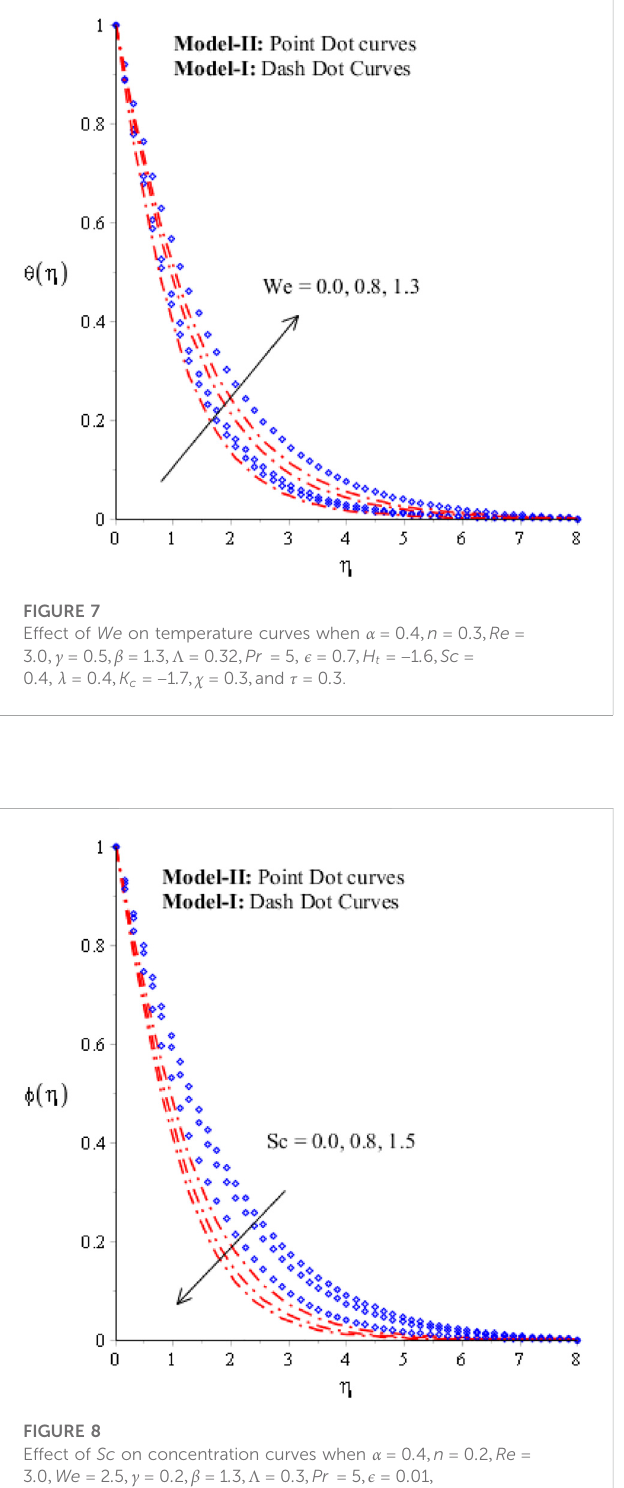
FIGURE 8 Effect of Sc on concentration curves when α (cid:2) 0 . 4 , n (cid:2) 0 . 2 , Re (cid:2) 3 . 0 , We (cid:2) 2 . 5 , γ (cid:2) 0 . 2 , β (cid:2) 1 . 3 , Λ (cid:2) 0 . 3 , Pr (cid:2) 5 , ϵ (cid:2) 0 . 01 , H t (cid:2) − 1 . 6 , λ (cid:2) 0 . 4 , γ (cid:2) 0 . 4 , K c (cid:2) − 1 . 5 , χ (cid:2) 0 . 3 , and τ (cid:2) 0 . 5.